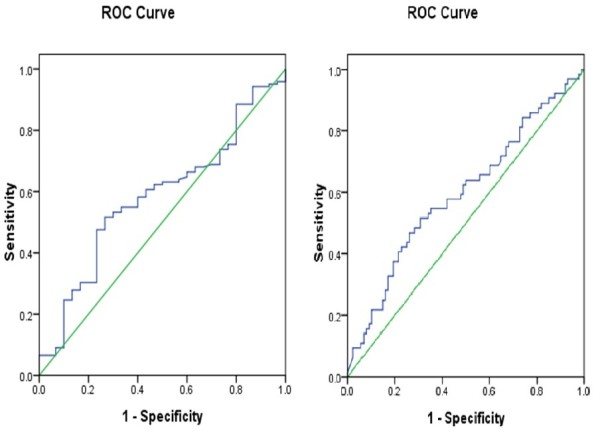
The ROC curve of NT pro-BNP levels and clinical diagnosis of HF (Figure A) and impaired renal function (Figure B). AUC = area under the curve; CI = confidence interval; ROC = receiver-operating characteristic.